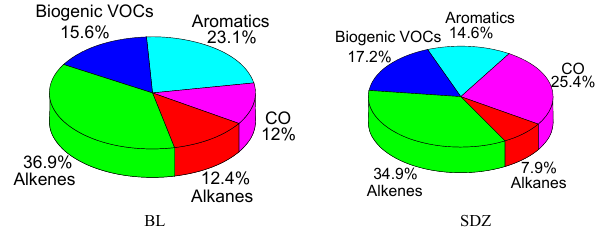
Fig. 5. Percentage contributions of alkanes, alkenes, biogenic Fig.5 Percentage contributions of alkanes, alkenes, biogenic VOCs, aromatics and carbon 2 VOCs, aromatics and carbon monoxide to total L OH at BL (left, monoxide to total L OH at BL (left, toal L OH : 57.6s -1 ) and SDZ (right, toal L OH : 21.2s -1 ) . 3 toal L OH : 57.6s − 1 ) and SDZ (right, toal L OH : 21.2s − 1 ).